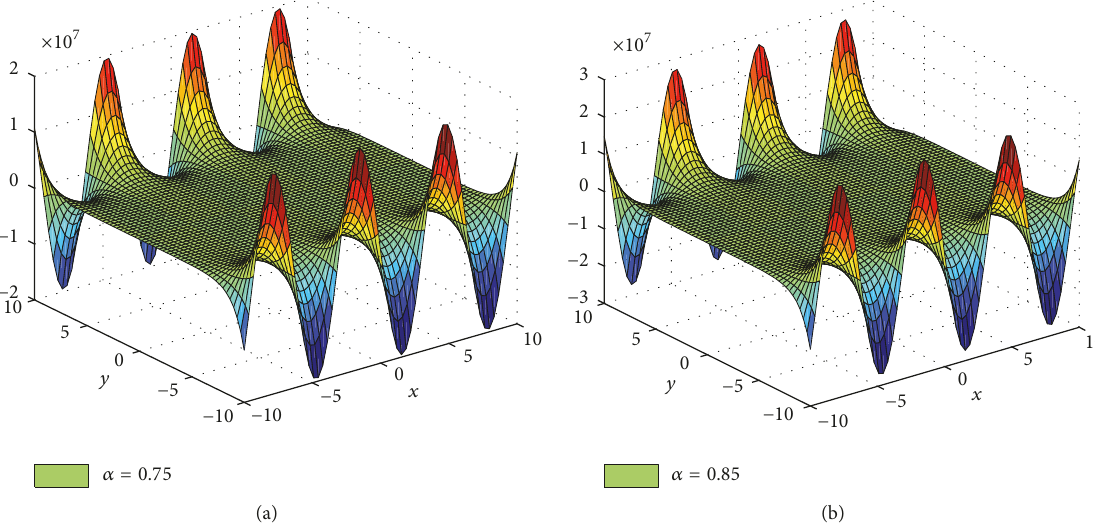
Figure 2: Numerical plots of approximate solutions of Example 7 at various fractional orders and using 𝑡 = 10.